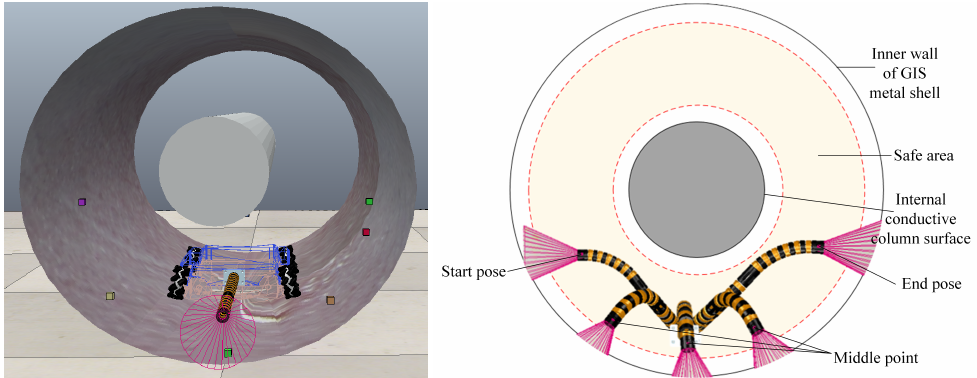
Figure 1. The diagram of the intracavitary